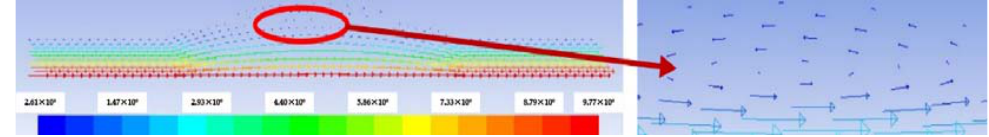
Figure 8. Flow field velocity vector diagram of arc ‐ shaped texture when h = 10 μ m .